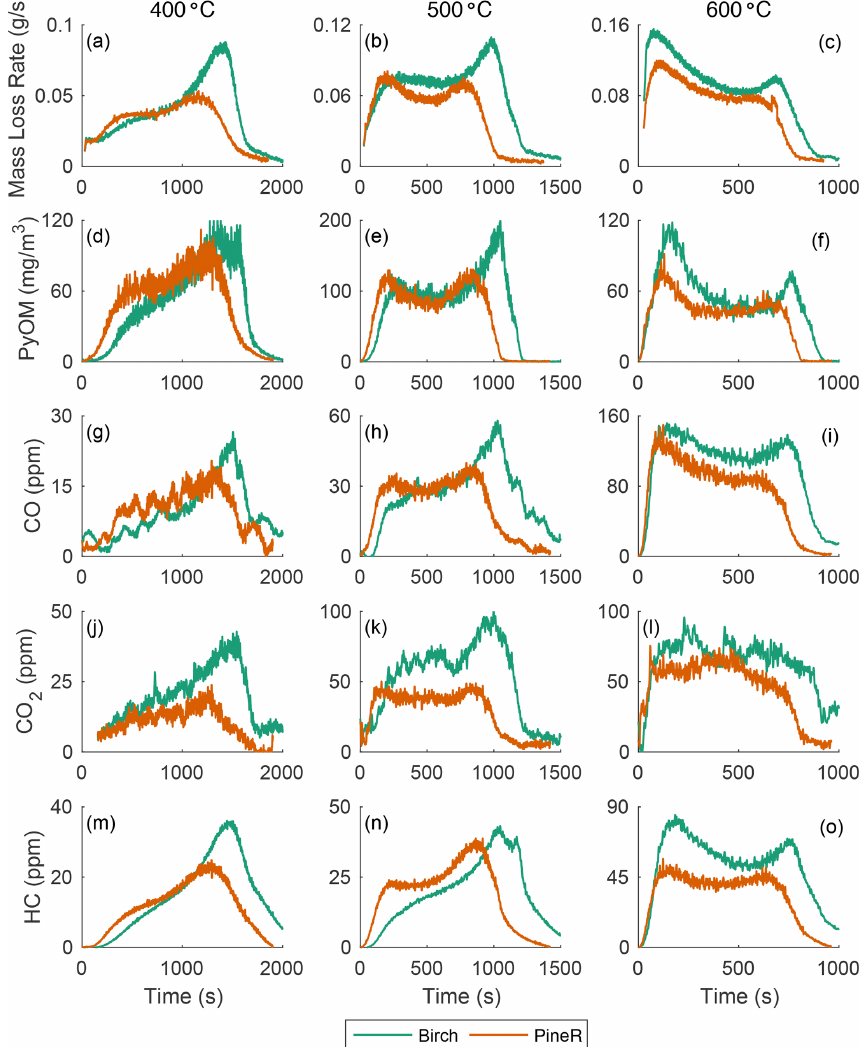
Figure 2. The mass loss rate and real-time concentration of particles and gases for birch and pineR at three reactor temperatures. Note the significant changes in the scales from plot to plot. Fluctuations in the CO 2 signals are due to noise near the detection limit.